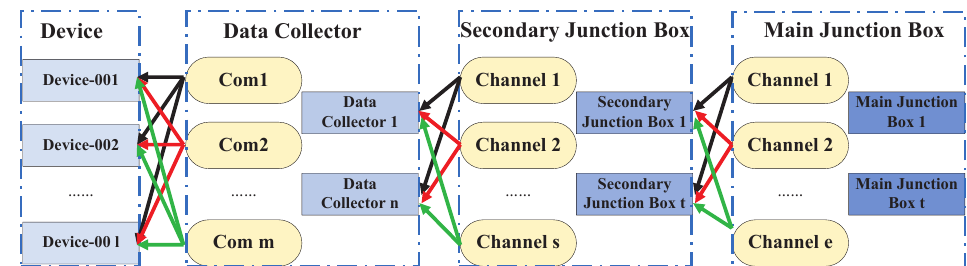
Figure 4. The mapping relationship of the